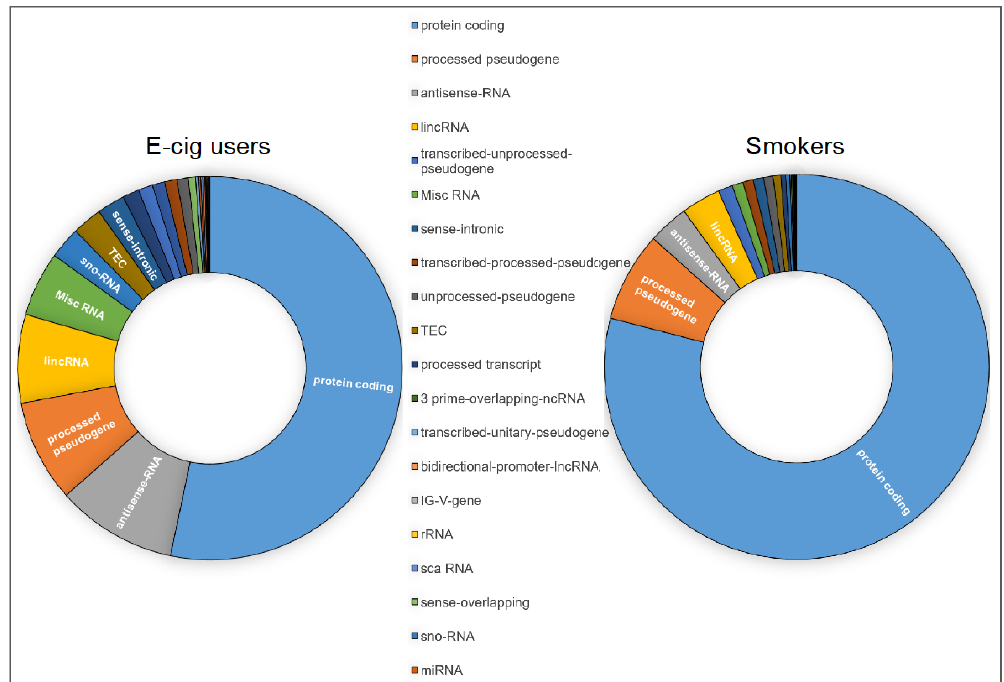
Figure 3. Categories of the aberrant transcripts detected in e-cig users and smokers relative to controls by IPA ® . High proportions of the aberrantly transcribed DNA sequences in e-cig users and smokers, respectively, belong to regulatory non-coding RNAs and protein-coding genes.